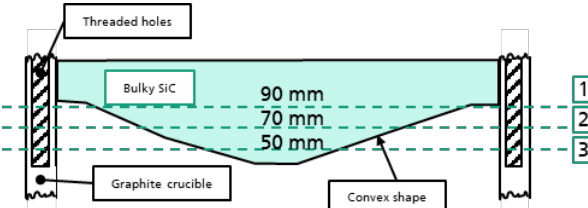
Figure 2. Scheme of the sample setup consisting of the convex shaped bulk SiC crystal and the surrounding graphite crucible. The different thickness layers relate to the convex shape of the crystal. The dotted lines indicate certain thicknesses analyzed in the reconstructed volume.